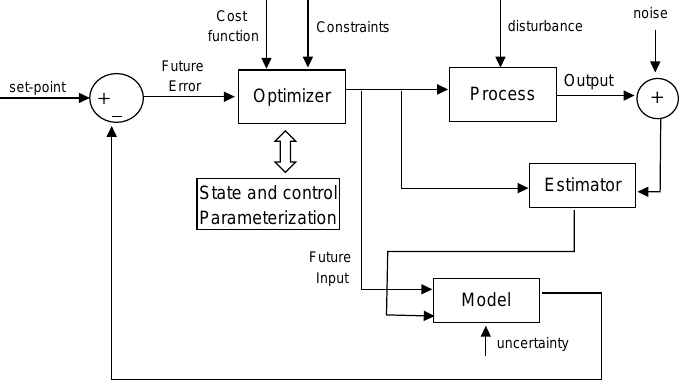
Figure 1. Predictive control configuration for the direct approach and state